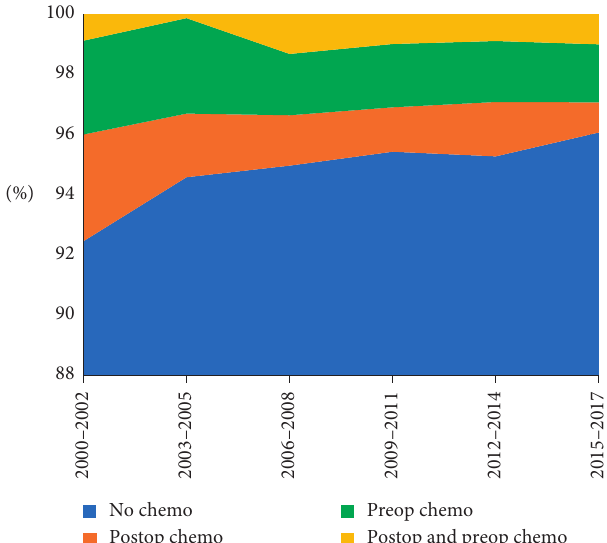
Figure 3: The use of perioperative chemotherapy for grades II and III resected soft tissue sarcoma in the Netherlands between 2000 and 2017. Abbreviations: chemo � chemotherapy, postop � postoperative, and preop � preoperative.